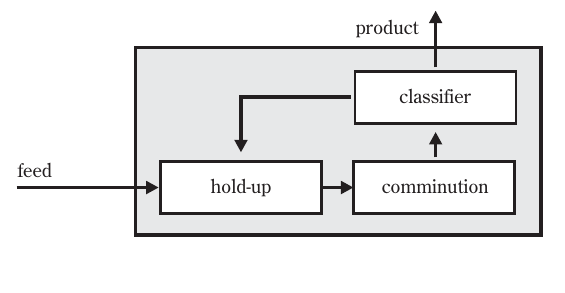
Fig. 7 Structure of the mill model